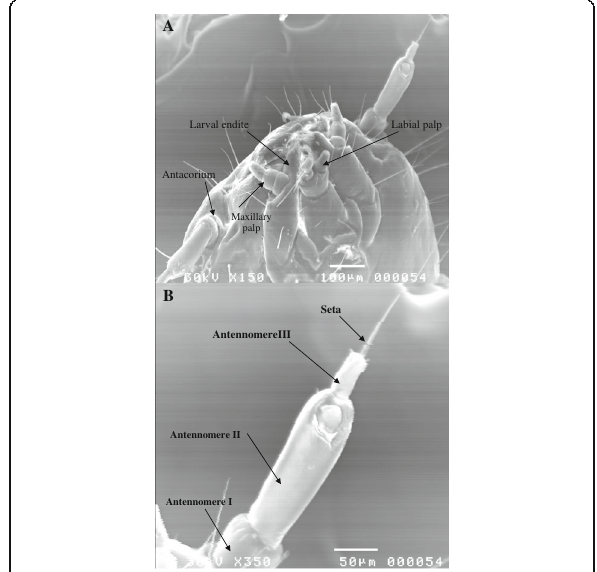
Fig. 6 a Higher magnification of ventral view of the last larval instar of T. confusum showing the mouth parts showing the maxilla having only three palp segments, the larval endites, the labial palps consists of two segments and the antacorium. b Higher magnification of the antenna of the last larval instar which consists of three segments terminates in a long seta